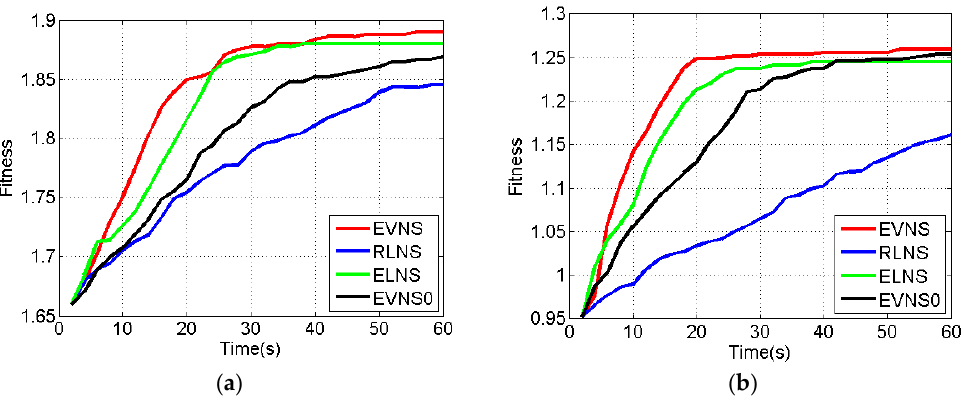
Figure 12. Fitness curve comparison of EVNS, RLNS, ELNS, and EVNS0: ( a ) Comparison under random disruption of 3000 suppliers; ( b ) Comparison under target disruption of 3000 suppliers. Table 4. Optimal solution fitness comparison of EVNS, RLNS, ELNS, and EVNS0. Random